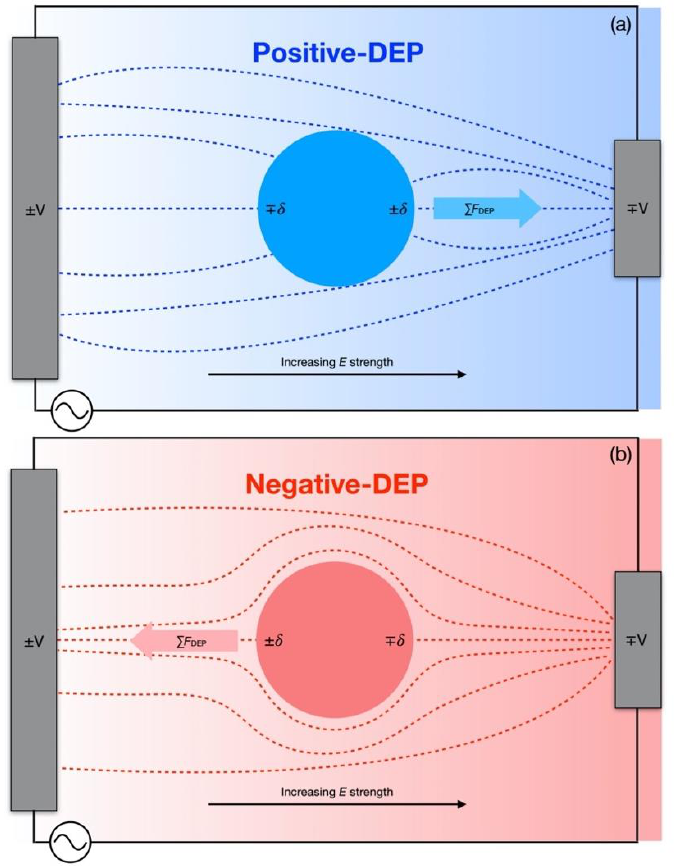
Figure 1. Direction of the cell translation based on its DEP response: ( a ) positive-DEP cell movement; and ( b ) negative-DEP cell movement (adapted from [22]).